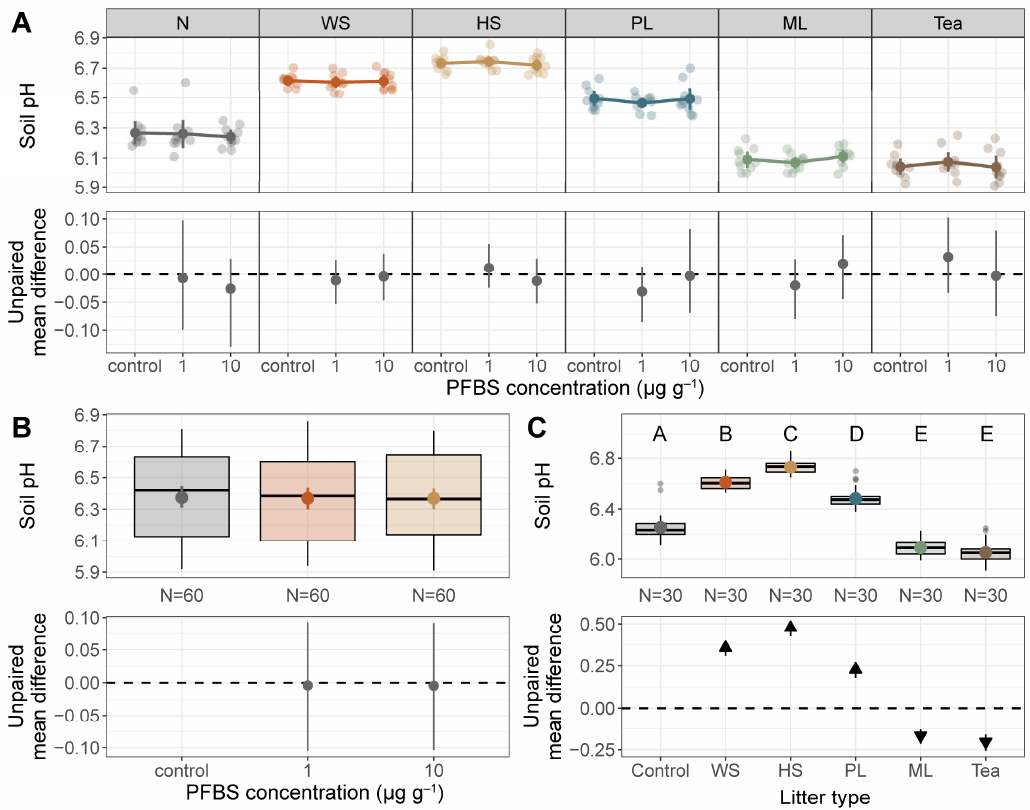
Figure 4. ( A ) Response of soil pH to PFBS treatments within litter type; ( B ) Response of soil pH to PFBS concentrations regardless of litter type; ( C) Response of soil pH to litter type regardless of PFBS concentrations. The second row of the panel ( A ) showed the comparison of the unpaired mean difference between the treated and the control group within a 95% confidence interval (CI), and the grey spots indicated the neutral effects. Different letters above the boxes in panel ( C ) indicated statistically significant differences among treatments at p < 0.05. N, no litter; WS, wheat straw; HS, hemp stem; PL, Plantago lanceolate ; ML, Medicago lupulina .